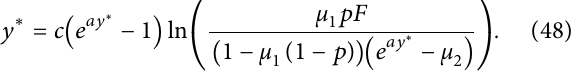
, μ , p,F,c ) � ( 1 , 0 . 1 , 0 . 8 , 5 , 0 . 5 ) and 1 2